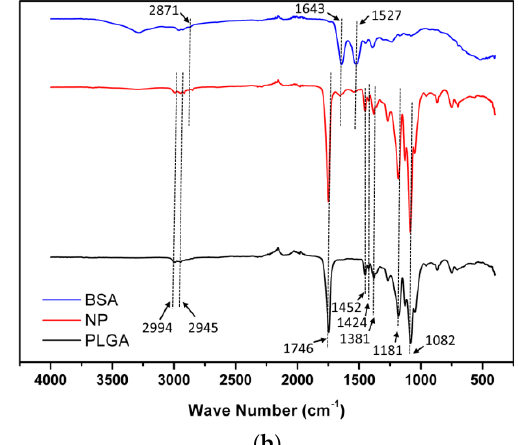
Table 2. Abbreviation and composition of the tested groups for particle behavior study.